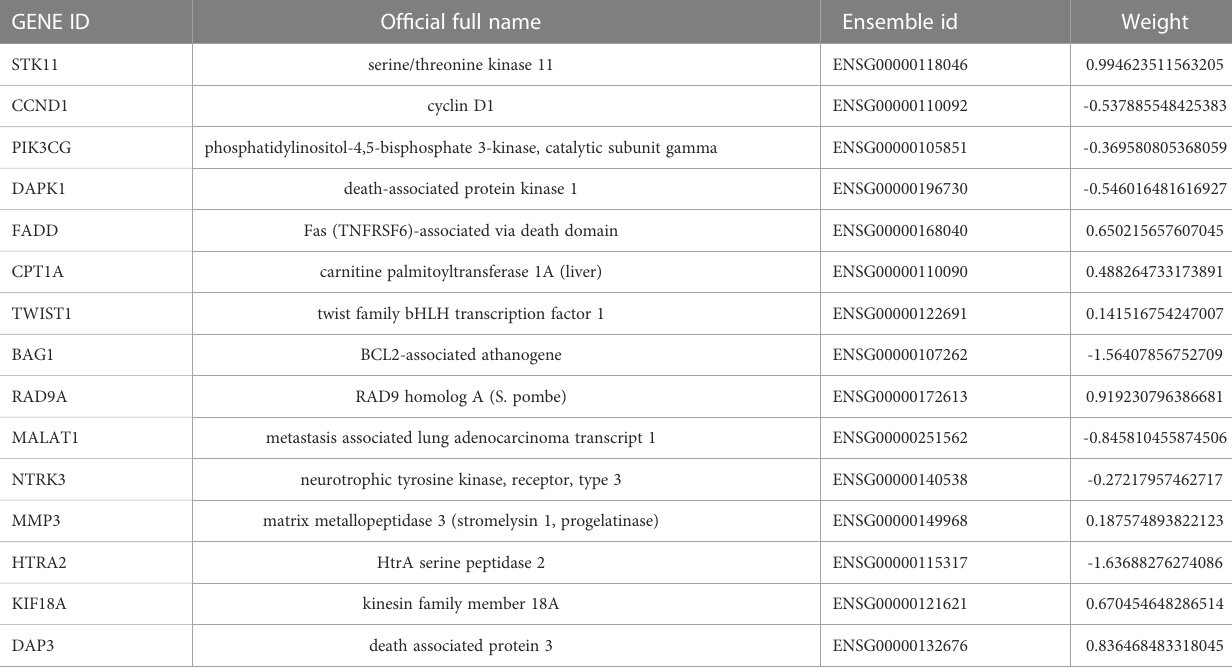
TABLE 1 15 key genes involved in anoikis-related prognostic model construction. GENE